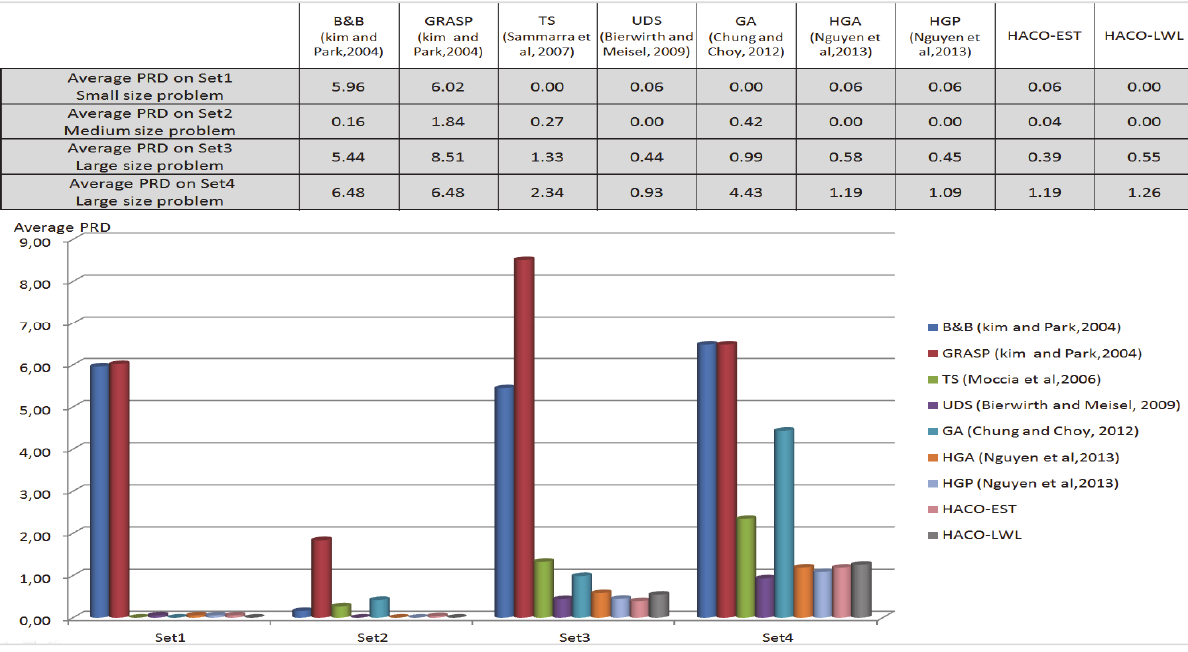
Fig 5 . Performance evaluation of optimization procedure versus existing